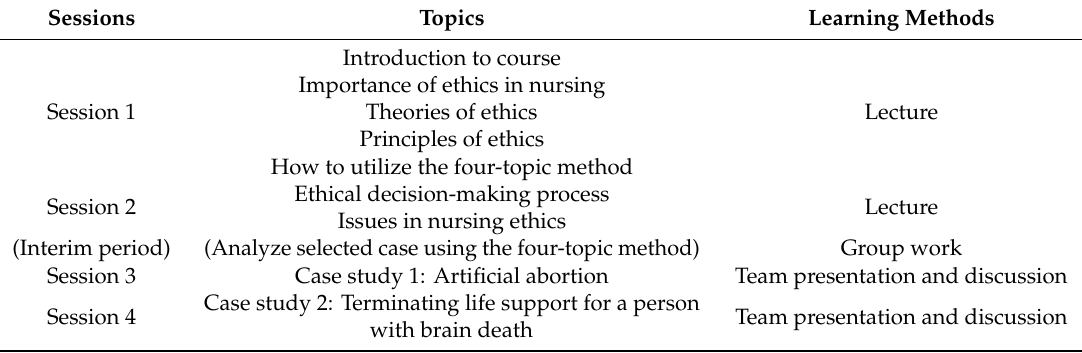
Table 1. Description of the educational